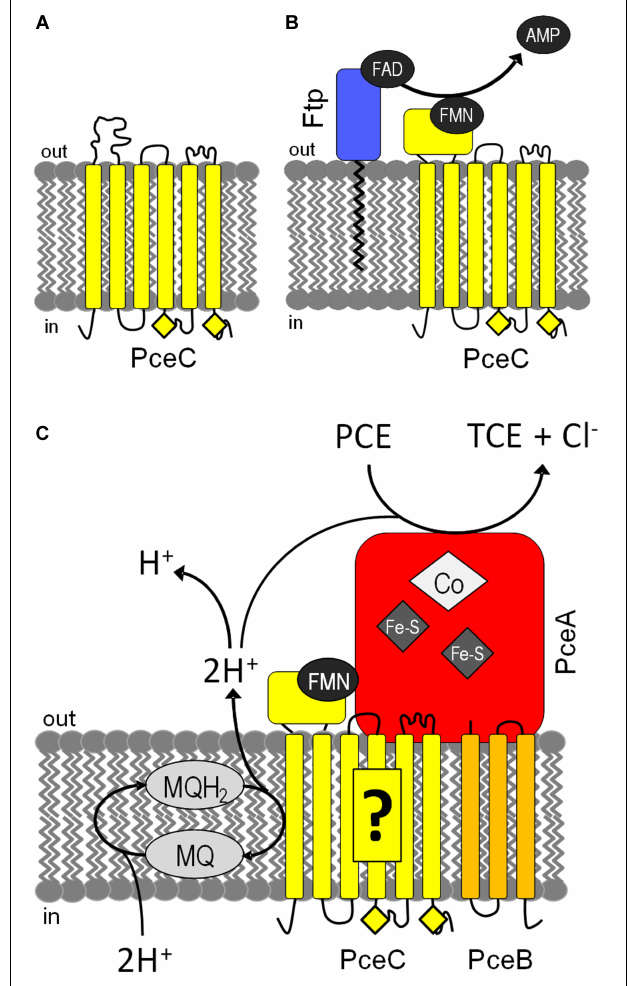
FIGURE 8 | Tentative models for the assembly and function of PceC in D. hafniense . (A) PceC (in yellow) is likely inserted in the cytoplasmic membrane while the FBD is in an unfolded state. (B) On the exocytoplasmic face of the membrane, Ftp (in blue) catalyzes the hydrolysis of FAD to FMN and AMP, and attaches FMN to the threonine-168 of PceC, resulting in the folding of the FBD. (C) PceC is hypothesized to build a protein complex with PceA (in red) and PceB (in orange), and to play the role of electron transfer from the menaquinol (MQ) pool to the redox centers of PceA via the FMN cofactor. Yellow diamonds represent the conserved CX 3 CP sequence